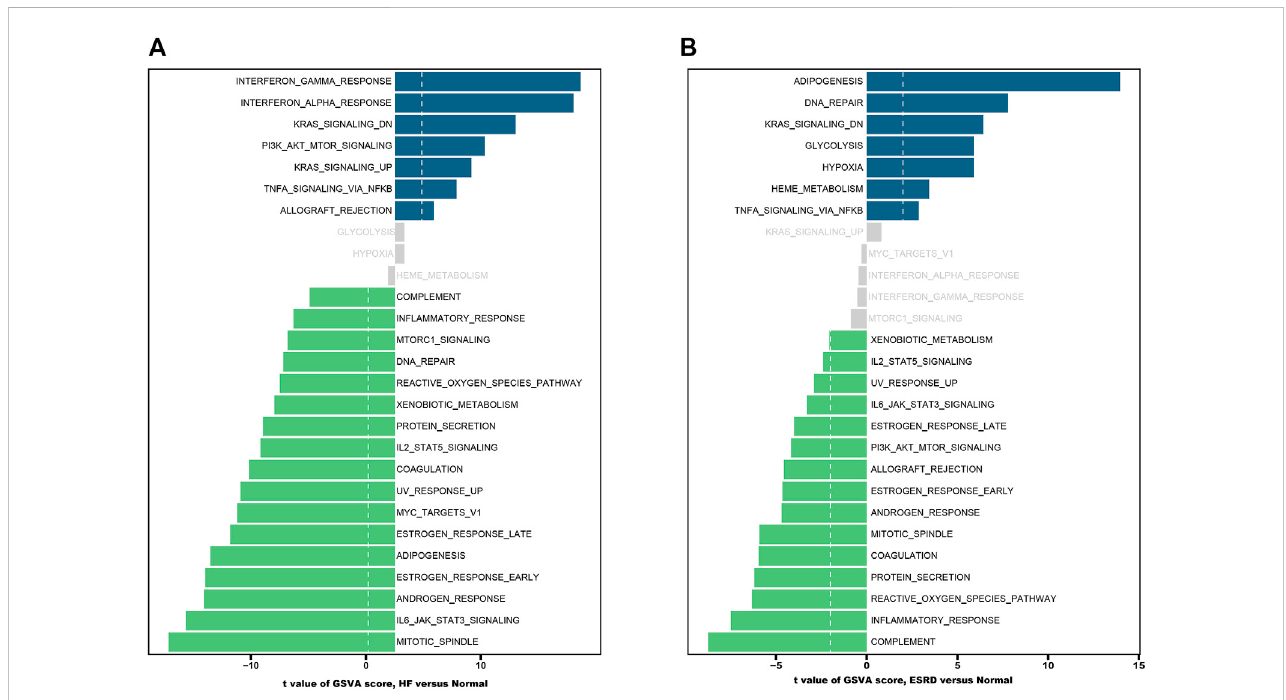
FIGURE 4 Functional and pathway analysis by GSVA enrichment analysis in HF and ESRD. (A) Signi fi cant related biological pathways in HF were obtained by GSVA. (B) Signi fi cant related biological pathways in ESRD were obtained by GSVA. The blue bars represent high expression, and the green bars represent low expression. HF, heart failure; ESRD, end-stage renal disease; GSVA, gene set variation